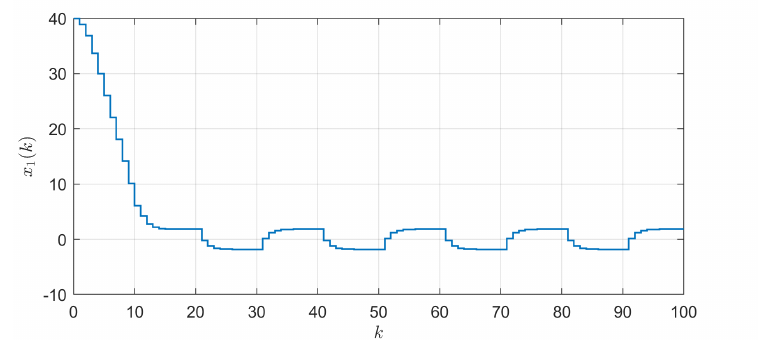
Figure 2. First state variable.